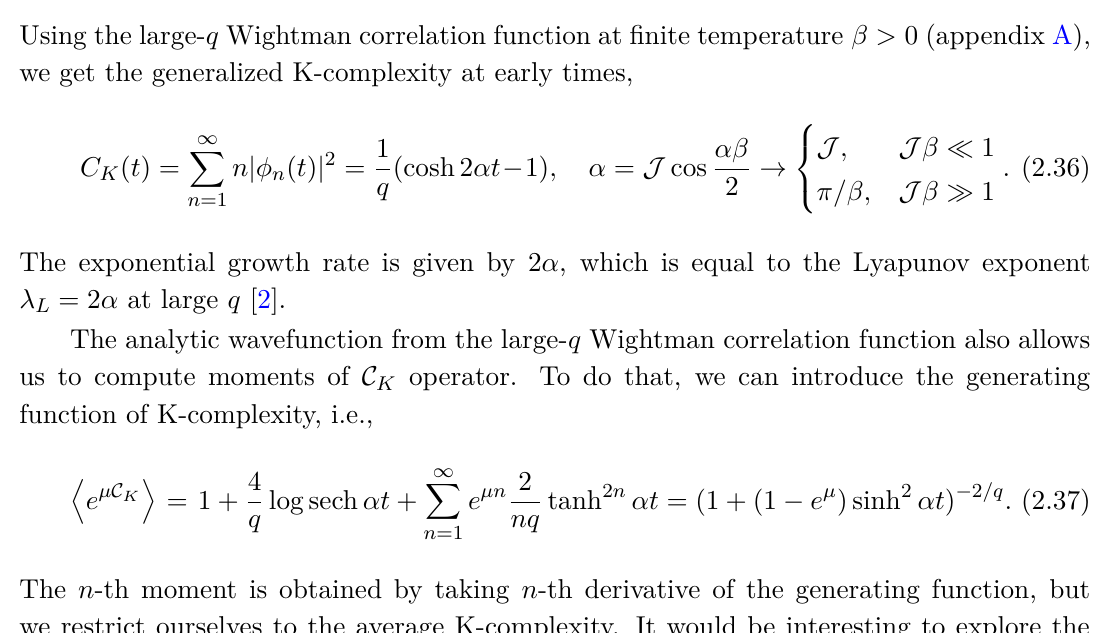
Figure 3 . (a) The Lanczos coefficient of the SYK model at different temperatures. The slope of the solid line is determined by 2 α ( β ) . We use the parameters N = 30 , q = 4 , J = 1 / K-complexity growth of a single Majorana fermion at different